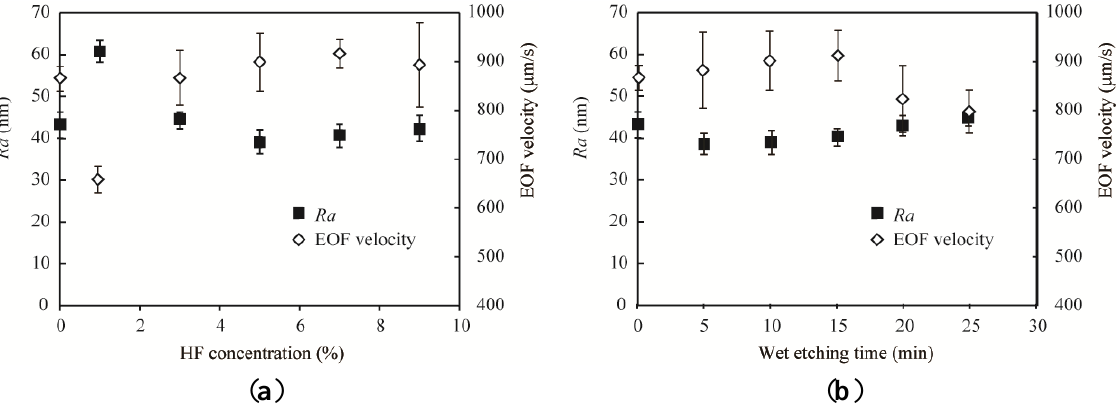
Figure 3. Surface roughness ( R hydrofluoric acid (HF) ( a ) with different HF concentrations and ( b ) for different etching